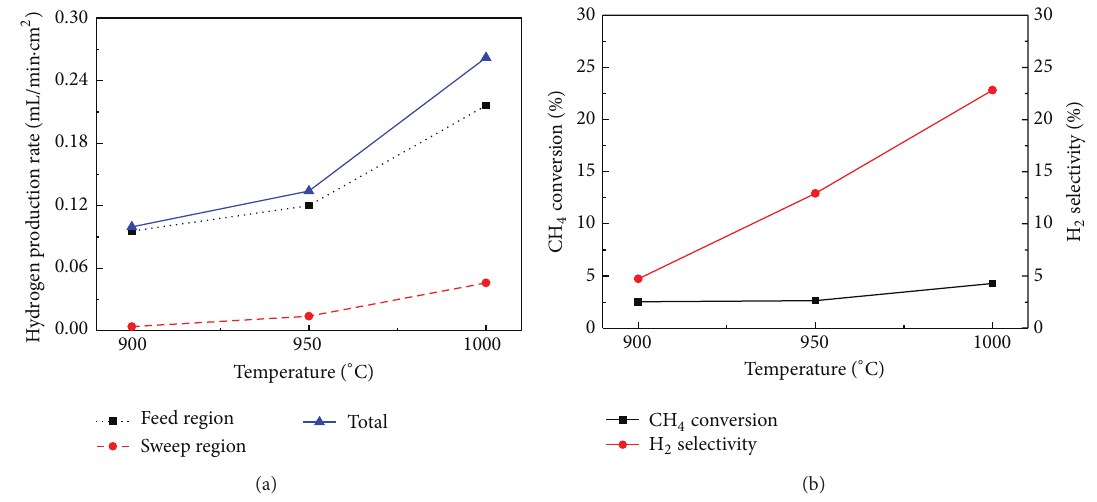
Figure 6: The catalytic properties of the microtubular LSTF membrane depending on temperature: (a) hydrogen production rate and (b) CH 4 conversion and H 2